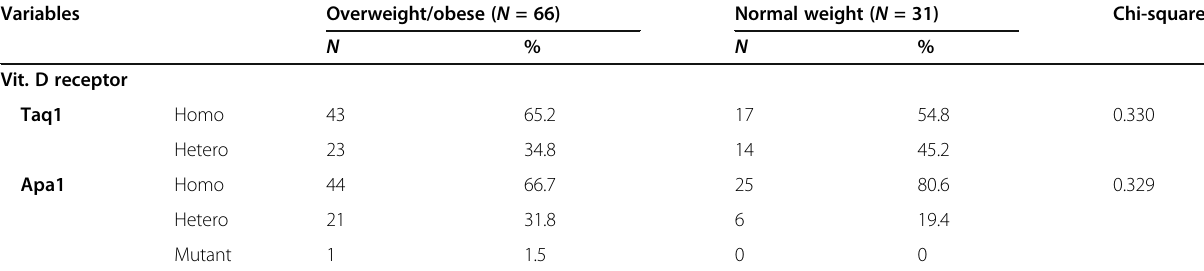
Table 2 Frequency distribution of TaqI and ApaI genotypes among overweight/obese and normal weight groups Variables